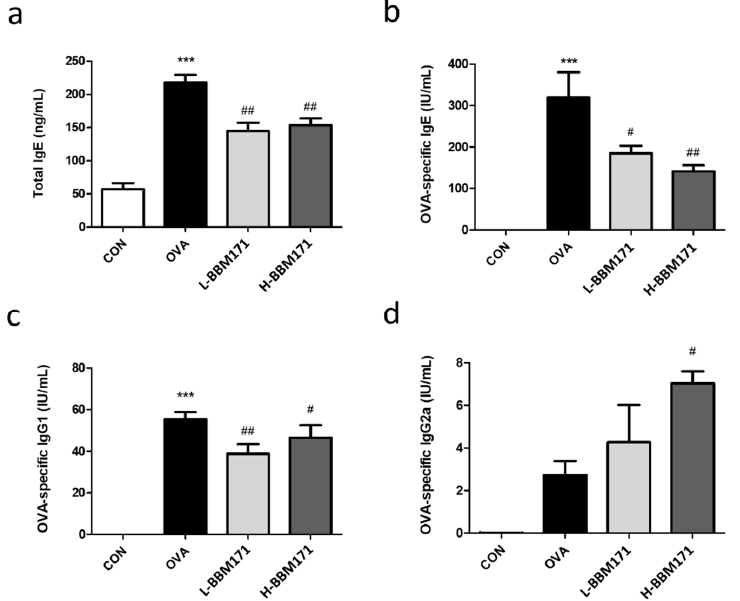
Figure 2. Effects of L. paragasseri BBM171 on the serum immunoglobulin levels in OVA-induced allergic mice. ( a ) IgE. ( b ) OVA-specific IgE. ( c ) OVA-specific IgG1. ( d ) OVA-specific IgG2. Data are expressed as mean ± SEM and analyzed by one-way ANOVA with Tukey’s post hoc test. Significant differences at *** p < 0.001 compared with the CON group. # p < 0.05 and ## p < 0.01 compared with the OVA group.